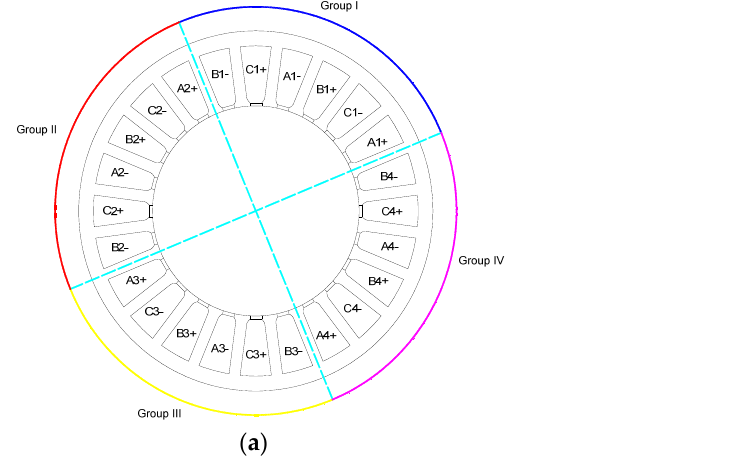
Figure 6. Radial cross section of the prototype: ( a ) stator; ( b ) rotor.